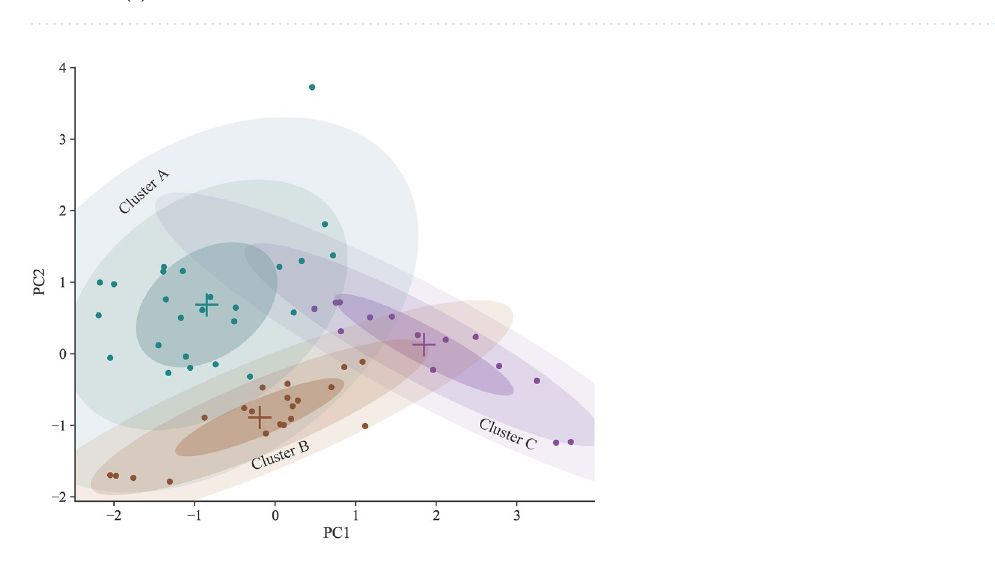
Figure 13. Clusters of algorithms’ solutions found by Gaussian mixture